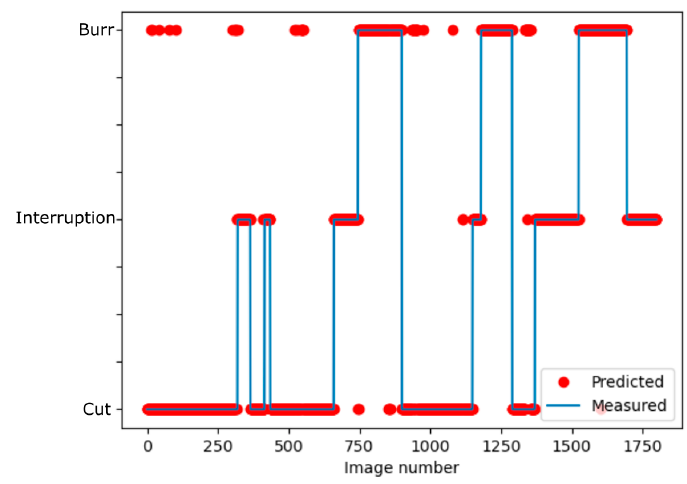
Figure 10. Measured image class and prediction by the neural network.